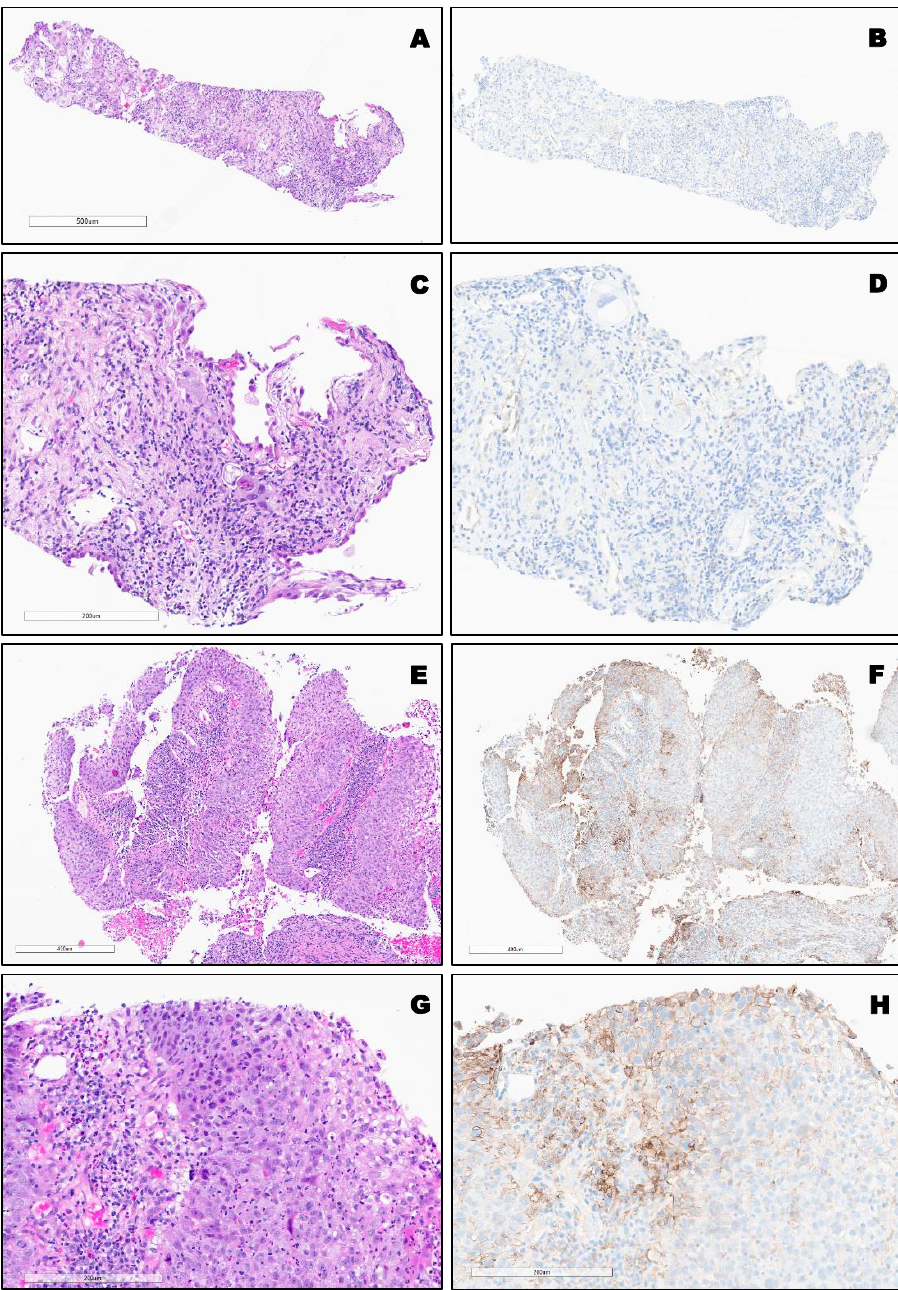
Figure 2. ( A – D ), Top SCC (TPS:0%). Bottom, ( E – H ): Moderately differentiated non-keratinizing SCC (TPS: 40%)